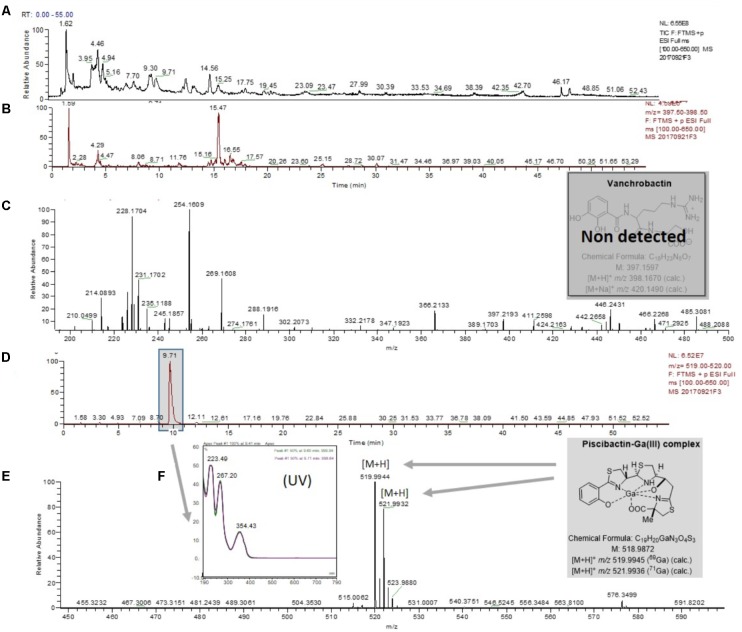
LC-MS experiments for the detection of piscibactin-Ga(III) complex in the RV22ΔvabF mutant strain. (A) Total ion chromatogram (TIC) of the fraction RV22ΔvabFF3 eluted with H2O-CH3CN (1:1) from the Oasis HLB cartridge. (B) Extracted mass chromatogram (m/z 397.50 to 398.50). (C) (+)-HRESIMS corresponding to retention time window from tR of 0.19–3.00 min which shows the lack of vanchrobactin. (D) Extracted mass chromatogram (m/z 519.00 to 520.00) showing the peak with retention time of 9.71 min. (E) (+)-HRESIMS of the peak at tR of 9.71 min identified as piscibactin-Ga(III) complex: m/z 519.9944/521.9922 ([M+H]+, calc. for C19H21N3O4S3Ga, 519.9950/521.9941). (F) UV spectrum of the peak at tR of 9.71 min.